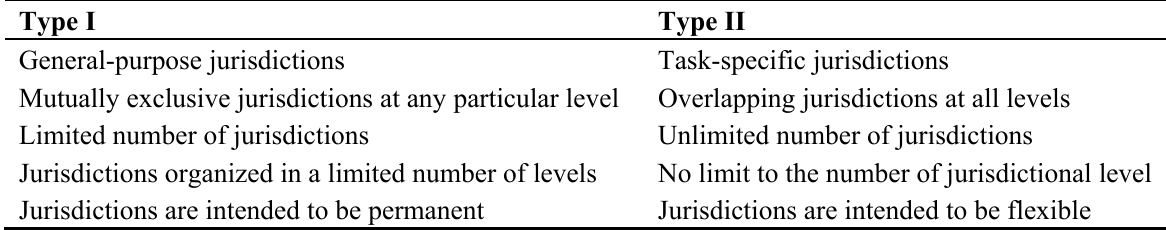
Table 1. Types of MLG.